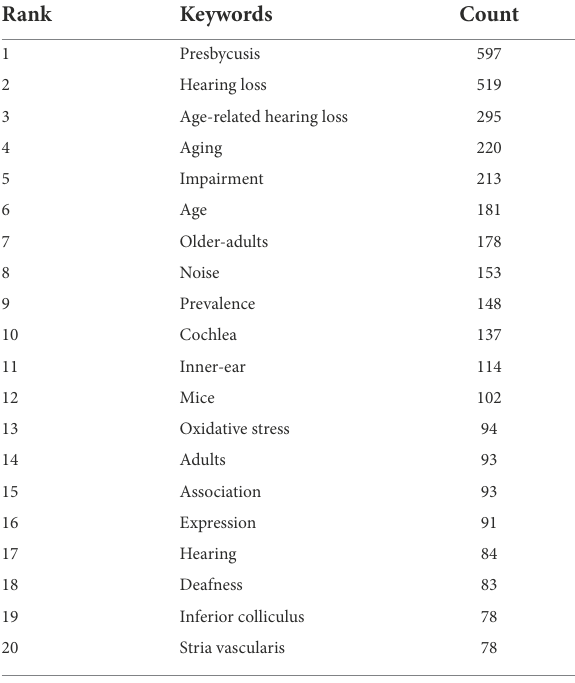
TABLE 2 Top 20 high-frequency keywords on aged-related hearing loss from 2002 to